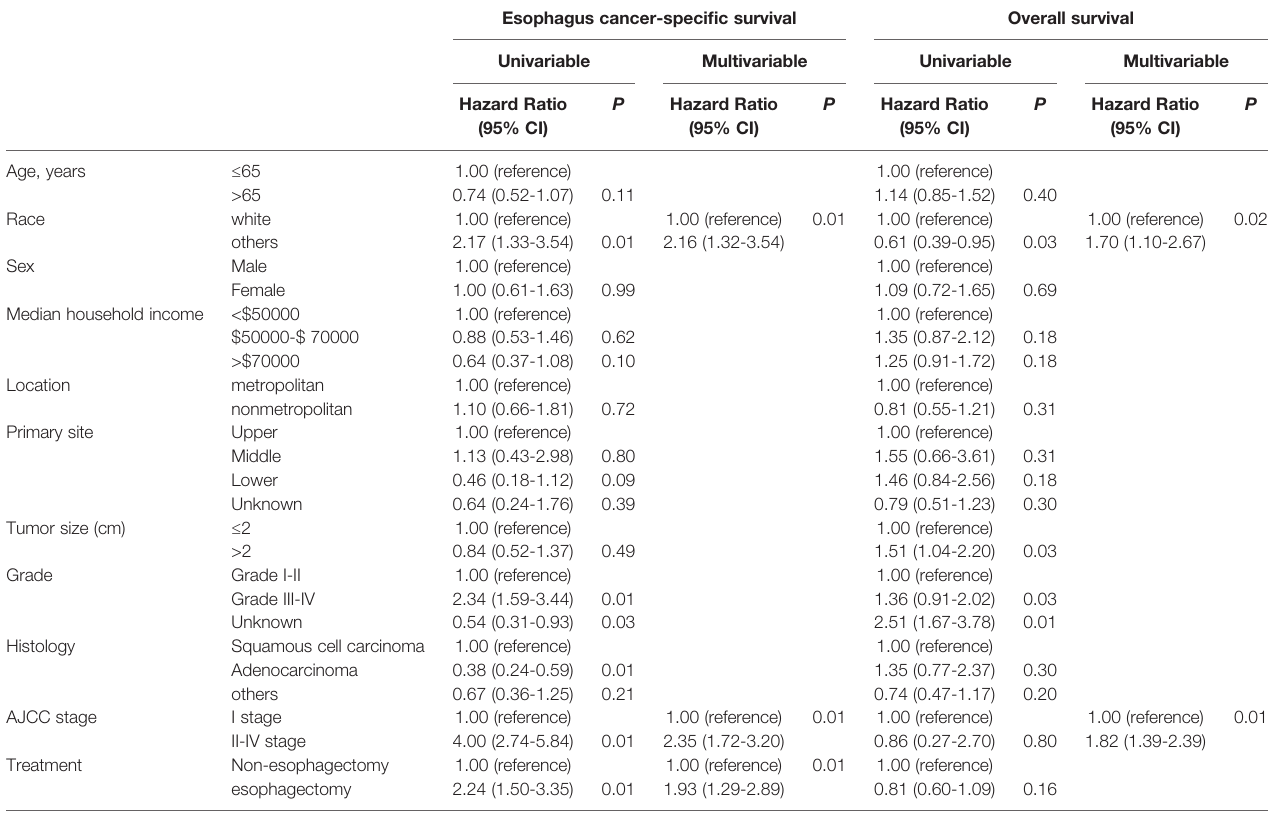
TABLE 2 | Cox proportional hazards regression model analysis for ECSS and OS in T1 stage esophagus cancer